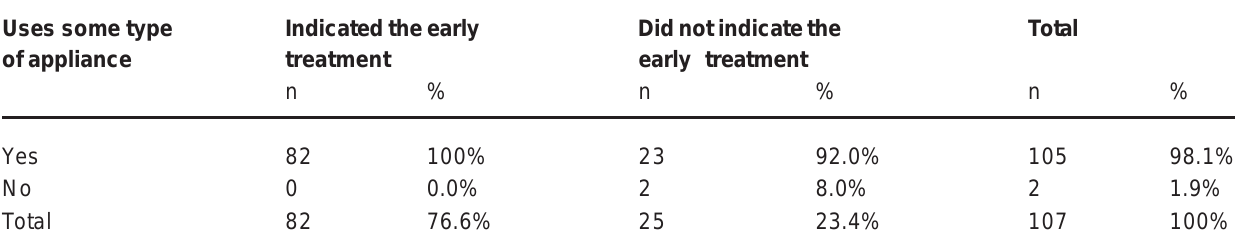
TABLE 1- Frequency of use of a determined appliance in the Class II malocclusion early treatment between groups that indicated and did not indicate the early treatment for the proposed clinical case (n=